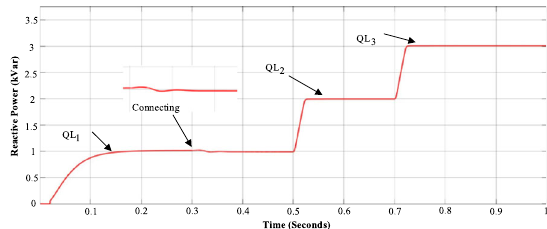
Fig. 11 Reactive power dynamics response at PCC